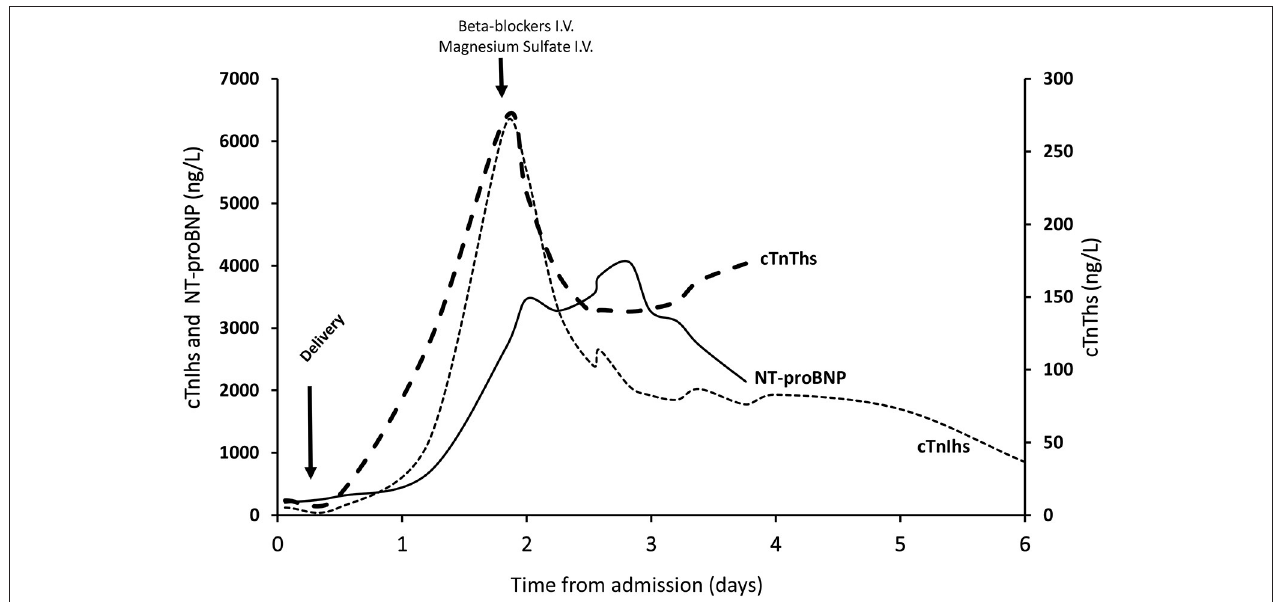
FIGURE 1 | Changes in the cardiac biomarkers cTnIhs, cTnThs, and NT-proBNP. Concentrations of circulating cardiac biomarkers were measured upon admission to hospital (day 0) and at intervals until to discharge (day 6). They are presented as ng/L. Delivery occurred between day 0 and 1 after admission. Intravenous (i.v.) magnesium sulfate and the beta-blocker labetalol were administered as